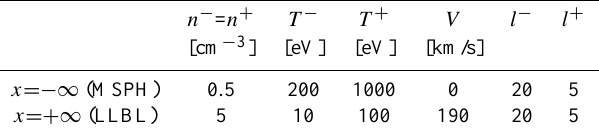
Table 1. Asymptotic values of the number density, temperature, bulk velocity of electrons (“ − ”) and protons (“ + ”) used to obtain the TD solutions illustrated by Figs. 2–3. The values of the pa- rameters l ± of each considered species are also given; l ± M,L parameter of the VDF that controls the width of the TD layer, as shown in the